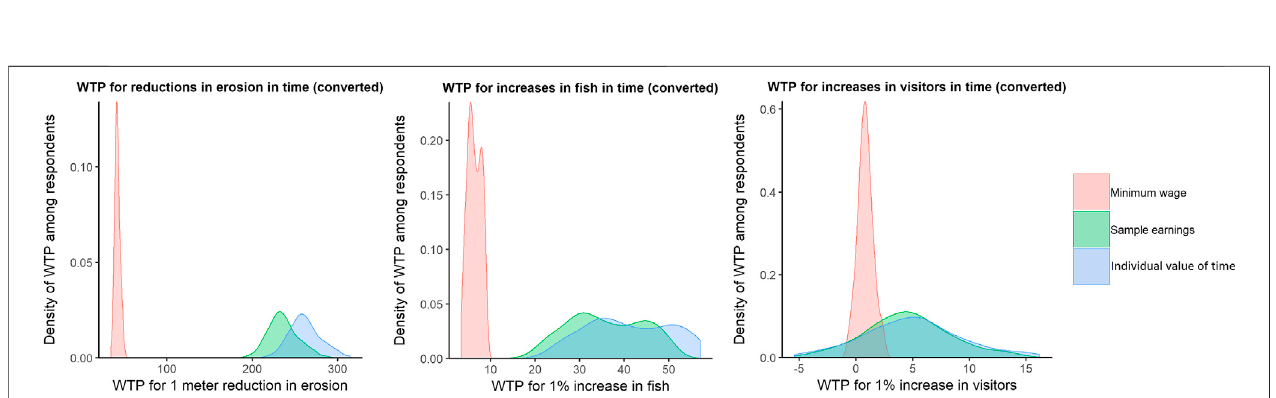
Frontiers in Environmental Science |